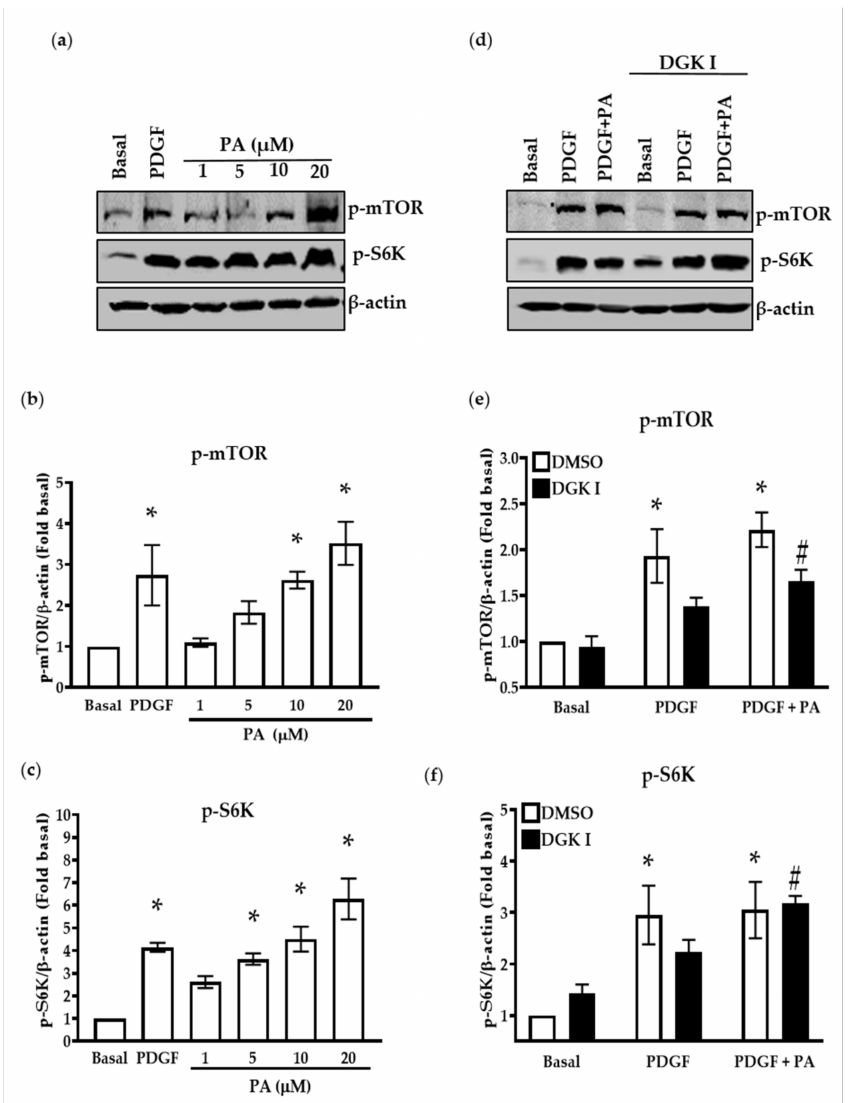
Figure 4. Effect of DGK inhibition and exogenous PA treatment on phosphorylation of mTOR and S6K. Human ASM cells were stimulated with PDGF (10 ng/mL) or PA (1 µ M–20 µ M) for 10 min. ( a ) Cells were lysed and immunoblotted for p-mTOR, p-S6K, and β -actin. Graphical representation of ( b ) p-mTOR and ( c ) p-S6K densitometry data from blots normalized to basal condition. ( d ) Human ASM cells were pre-treated with DGKI (30 µ M) for 15 min and then stimulated with PDGF (10 ng/mL) or PDGF (10 ng/mL) with PA (10 µ M) for 10 min, lysed, and immunoblotted for p-mTOR, p-S6K, and β -actin. Graphical representation of ( e ) p-mTOR and ( f ) p-S6K densitometry data from blots normalized to basal condition. Data above are mean ± SEM from n = 4–6 independent donors. * p < 0.05 compared to basal, # p < 0.05 DGKI (PDGF vs. PDGF + PA) using one-way ANOVA with Bonferroni post-hoc analysis. PA: Phosphatidic